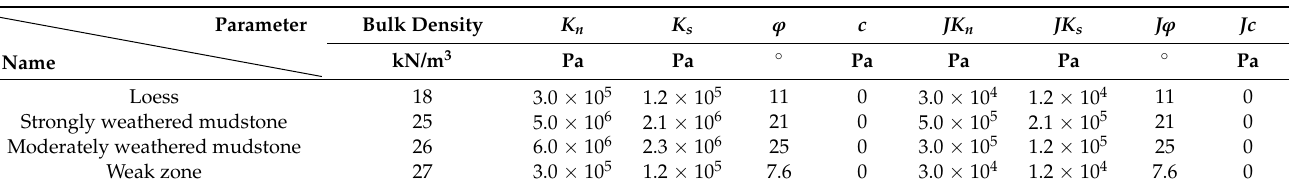
Table 1. Calculation parameters of discrete element numerical simulation before landslide in the Tanshan Coal Mine.